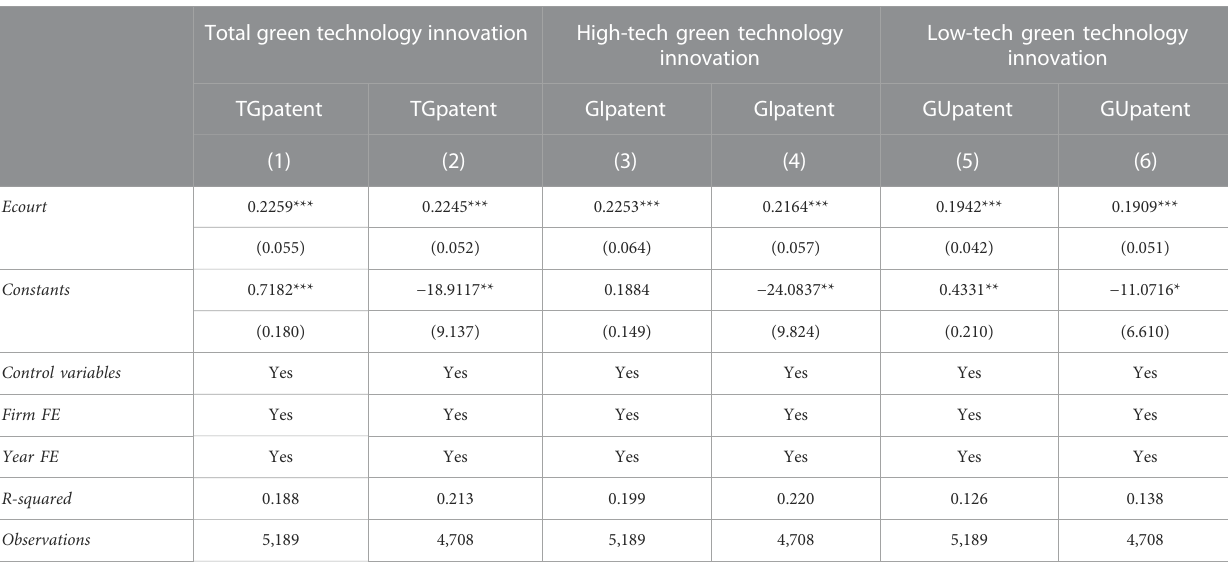
TABLE 4 PSM-DID estimation.